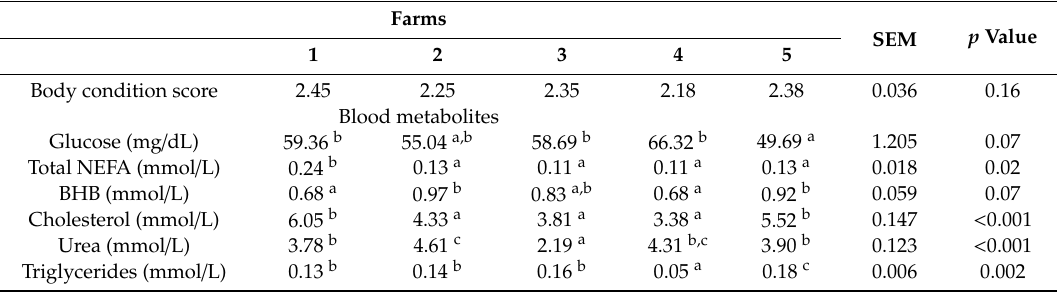
Table A2. LS means of blood fatty acid concentrations, metabolites and hormones in early lactation Holstein cows in the 5 farms of the